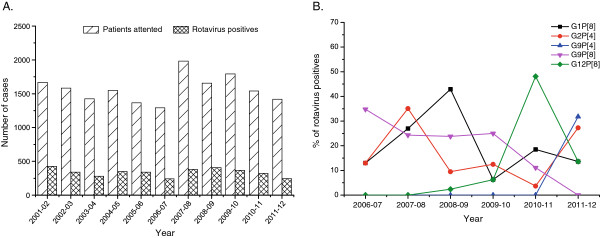
Prevalence and genotype distribution of rotaviruses in Matlab, Bangladesh. A: Number of diarrhea patients attended and number of cases tested rotavirus positive, June 2001-May 2012. B: Temporal changes in the distribution of major rotavirus genotypes, June 2006-May 2012.